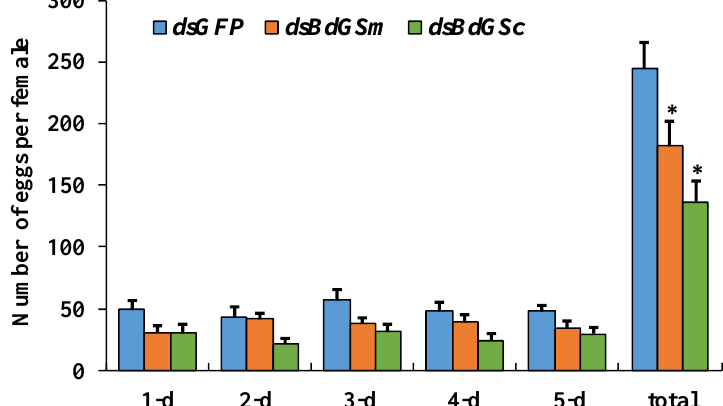
Figure 4. Egg-laying of females when silenced by double-stranded RNA of BdGSs . The bar represents the mean number of eggs ( n = 10), and the error bar represents the positive standard error of the mean. The asterisk above the bar indicates a significant difference compared with the control as analyzed by Student’s t -test using SPSS 19.0 (* P < 0.05).